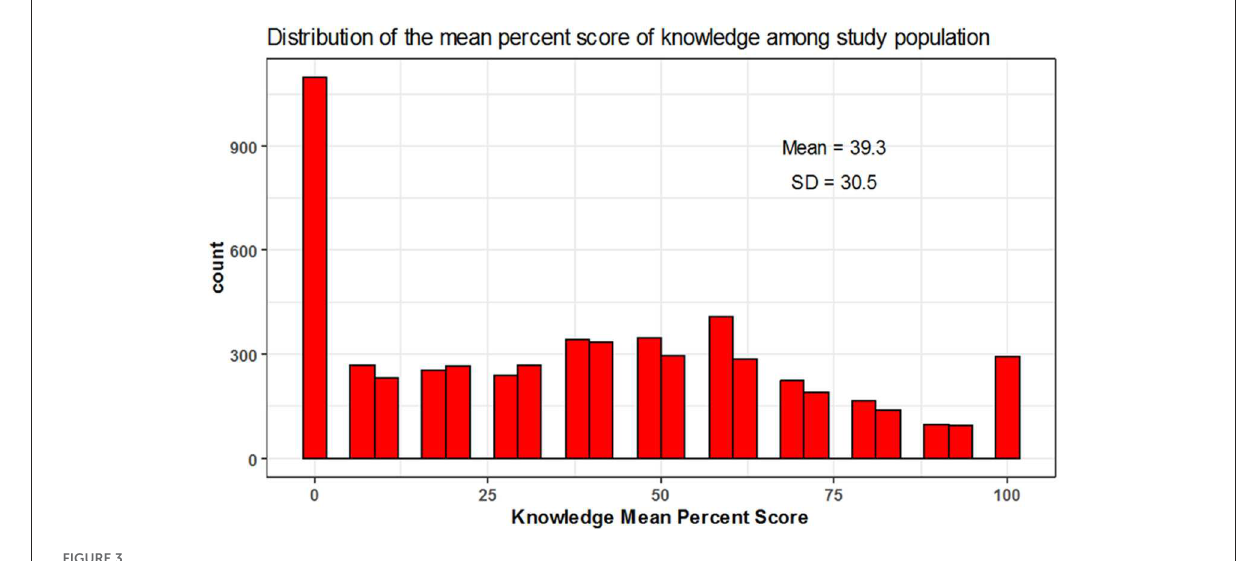
FIGURE3 Mean percent score distribution for knowledge.